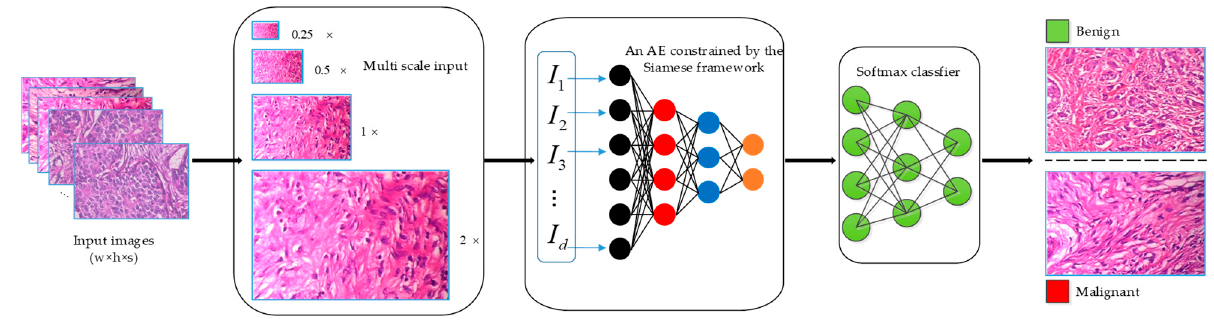
Figure 3. The procedure of the proposed method for breast histopathology image classification. Multi-scale input is used to simultaneously learn the global features and local texture information of histopathology images at different scales. The image is transformed into five different scales (0.125 × , 0.25 × , 0.5 × , 1 × , and 2 × ), thus enhancing the recognition of important areas in the image and overcoming the limitation of fixed receptive fields in spatial regions at different scales